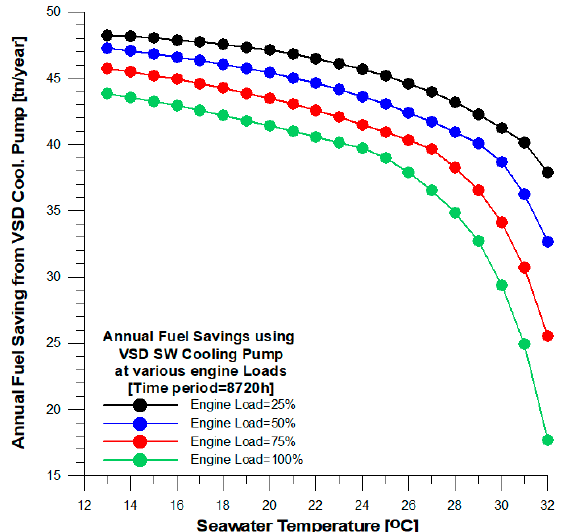
Figure 10. Estimation of the annual (8720 h) fuel savings obtained substituting constant speed cooling pump with a VSD one (based on SW mass flow rates calculated using the proposed HX-model), for various cooling loads and SW temperatures